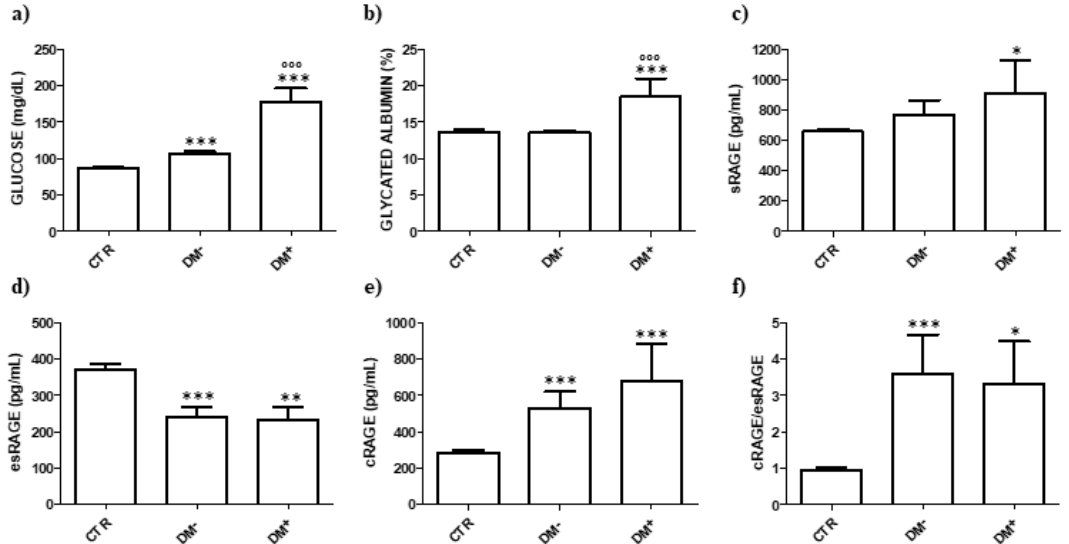
Figure 1. ( a ) Blood glucose, ( b ) glycated albumin, ( c ) sRAGE (soluble receptor for advanced glycation end products), ( d ) esRAGE (endogenously secretory receptor for advanced glycation end products), ( e ) cRAGE (membrane-cleaved receptor for advanced glycation end products), and ( f ) cRAGE/esRAGE ratio in COVID-19 (coronavirus disease-19) patients with and without diabetes mellitus (DM). CTR, healthy individuals; DM − , COVID-19 patients without DM; DM+, COVID-19 patients with DM. * p < 0.05 vs. CTR, ** p < 0.01 vs. CTR, *** p < 0.001 vs. CTR, °°° p < 0.001 vs. DM-.